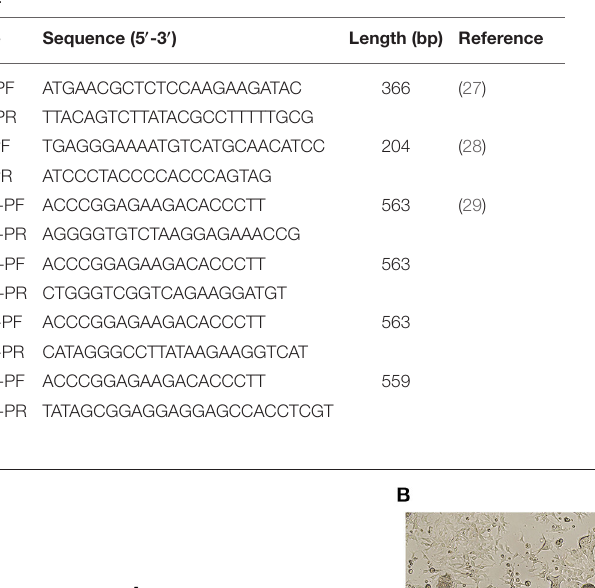
TABLE 2 | Primers for PCR detection of CIAV, REV, ALV-A, ALV-B, ALV-J, and ALV-K.